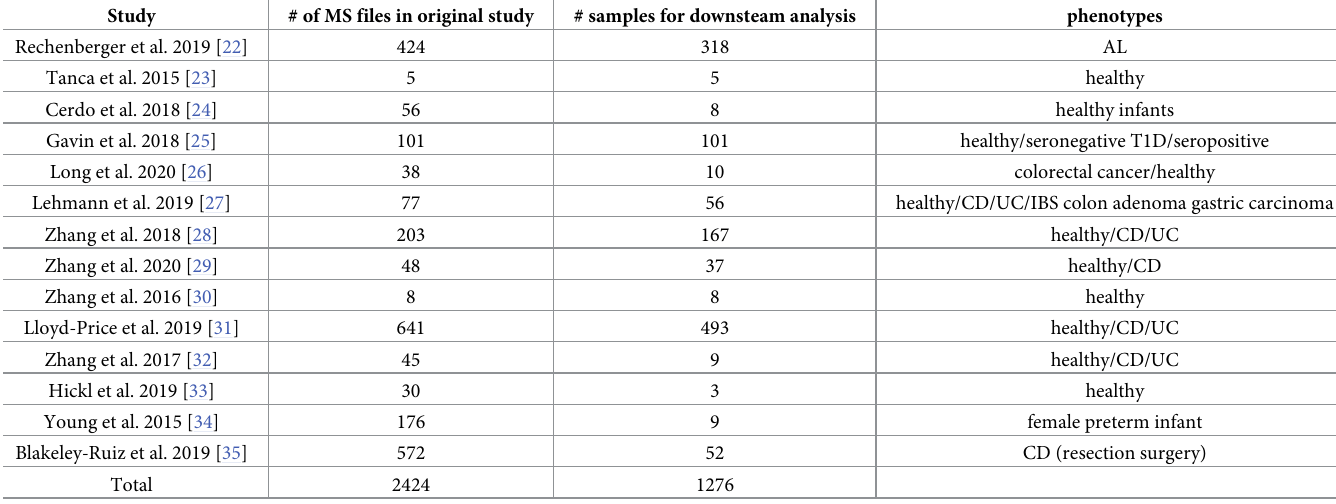
Table 1. Summary of the metaproteomics datasets that were